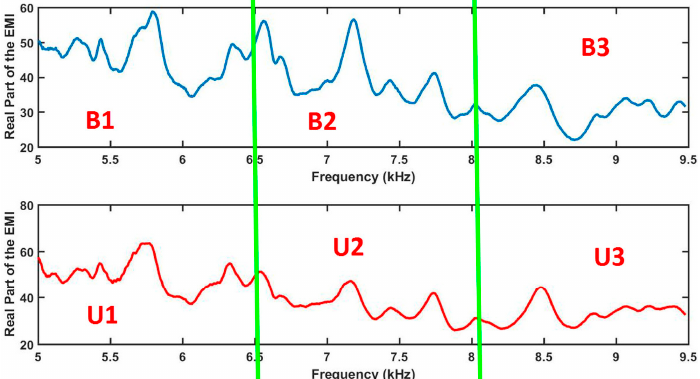
Figure 6. Division of the EMI signals for the baseline (top) and unknown (bottom) structural conditions before computing ED.